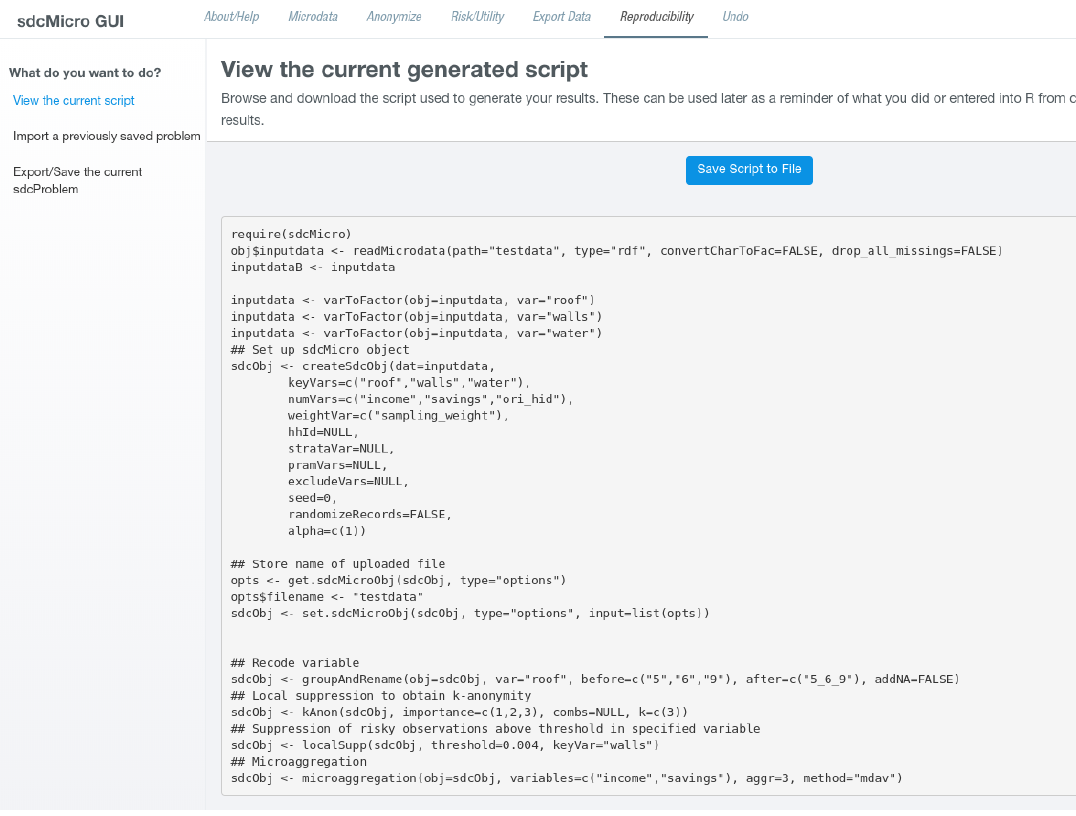
Figure 4. View/analyze the required code to reproduce the current